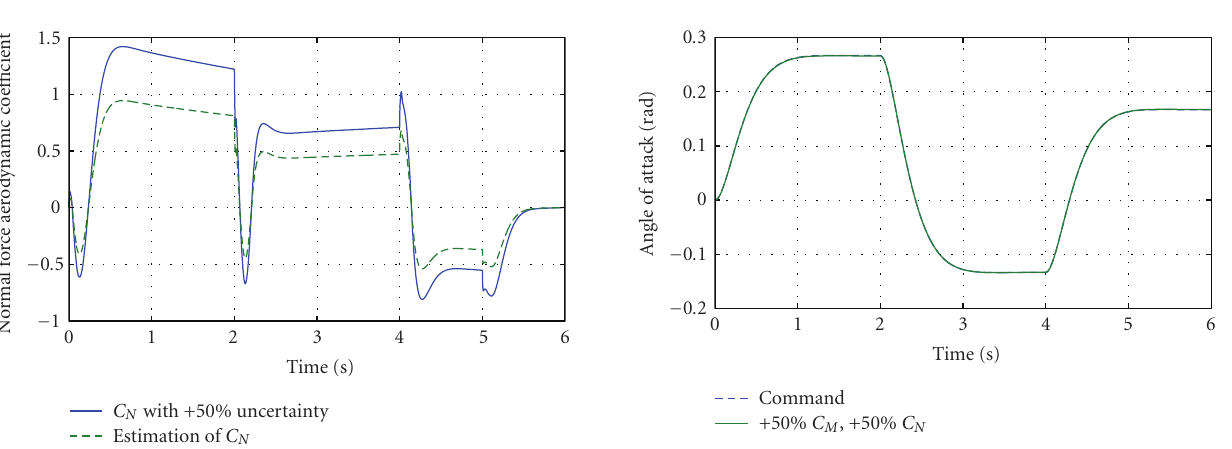
Figure 7: Angle of attack for a sequence of step command with parameter